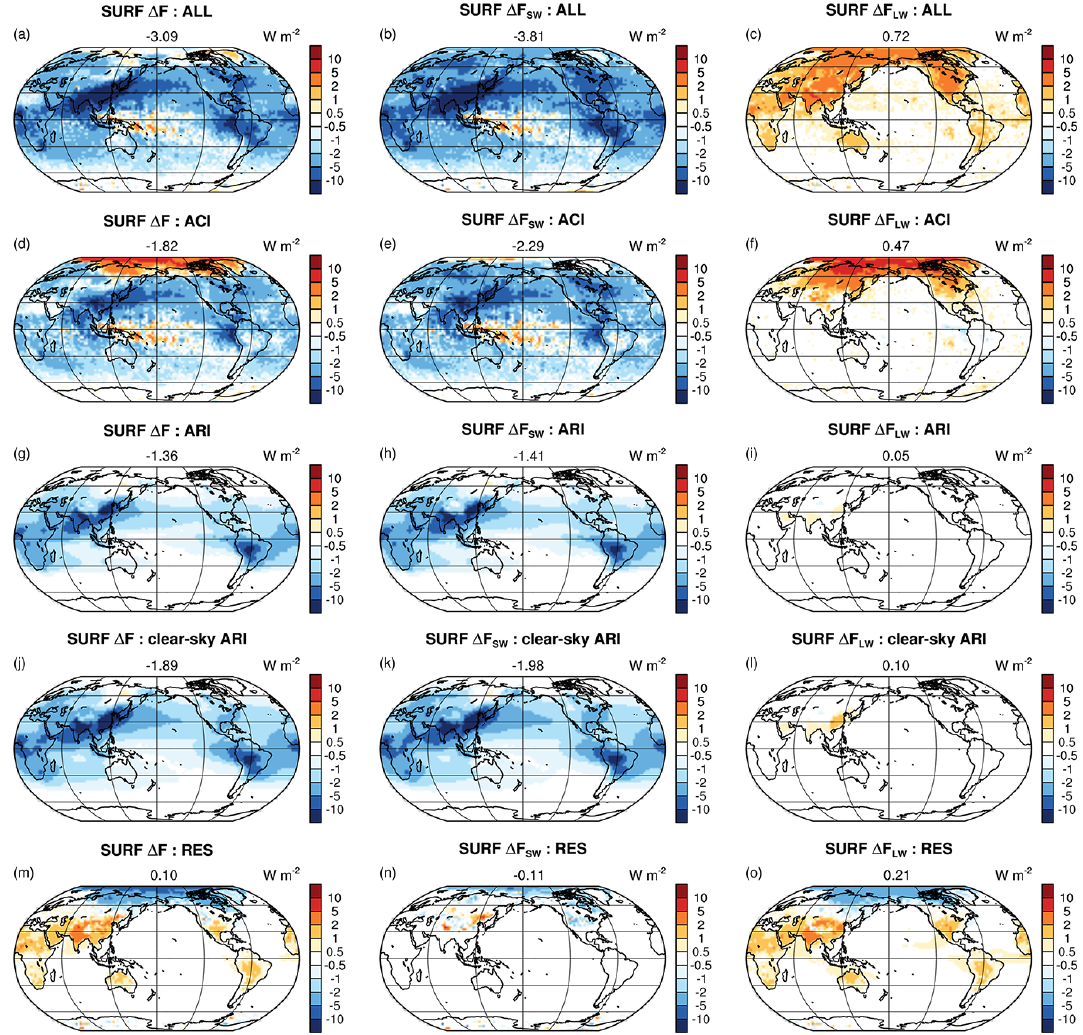
Figure 14. Geographical distributions of decomposed net (left column), shortwave (middle column), and longwave (right column) (cid:49) F at the surface. The decomposition calculation follows Ghan (2013). ALL indicates the total (cid:49) F calculated from the difference between CTRL and E1850 (ALL = ARI + ACI + RES). ACI indicates the (cid:49) F caused by aerosol–cloud interactions (second row), ARI the (cid:49) F caused by aerosol–radiation interactions (third row), and RES (bottom row) the residual forcing. The clear-sky ARI (fourth row) is also shown. See Sect. 5.1 for